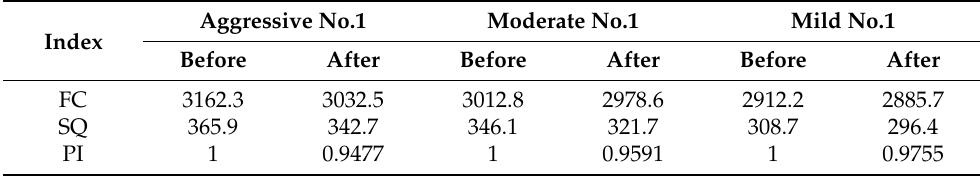
Table 6. Performance index comparison among three styled